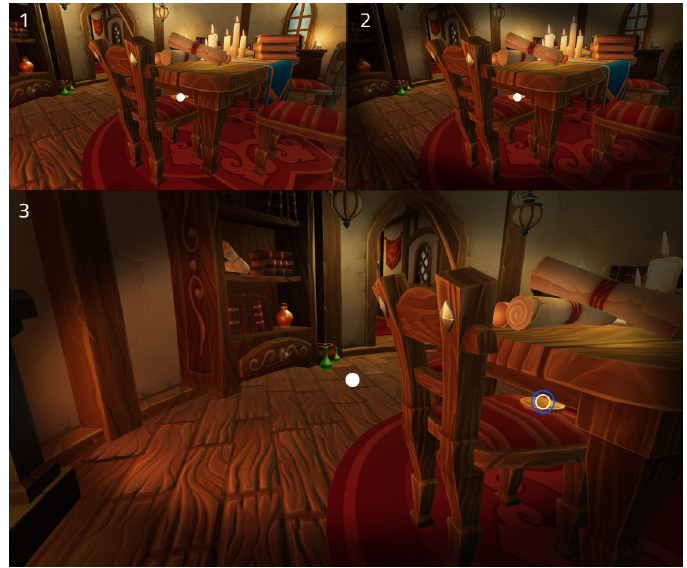
Figure 3. The study consisted of three conditions: 1—the No Guidance Condition (NoG) served as a control condition, and provided a crosshair, but no guidance features; 2—the Crosshair Guidance Condition (CrossG) included guidance through the proximity of the crosshair (white circle) in regard to the gold coins; the closer the crosshair was to a gold coin, the stronger the vignette effect was set; 3— Gaze-based Guidance Condition (GazeG) the guidance was achieved through the player’s gaze position; the crosshair in this condition was only used to pick up